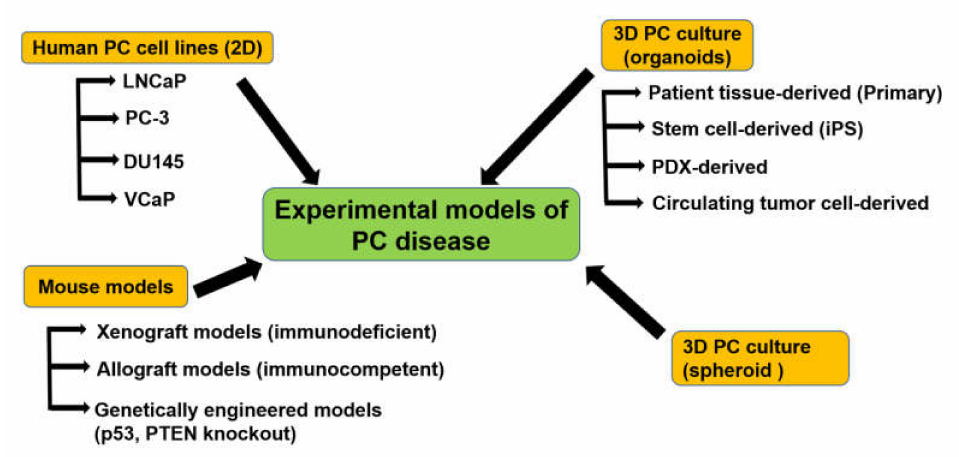
Figure 2. Main models to study PC disease and their subtypes. PDX: Patient-derived